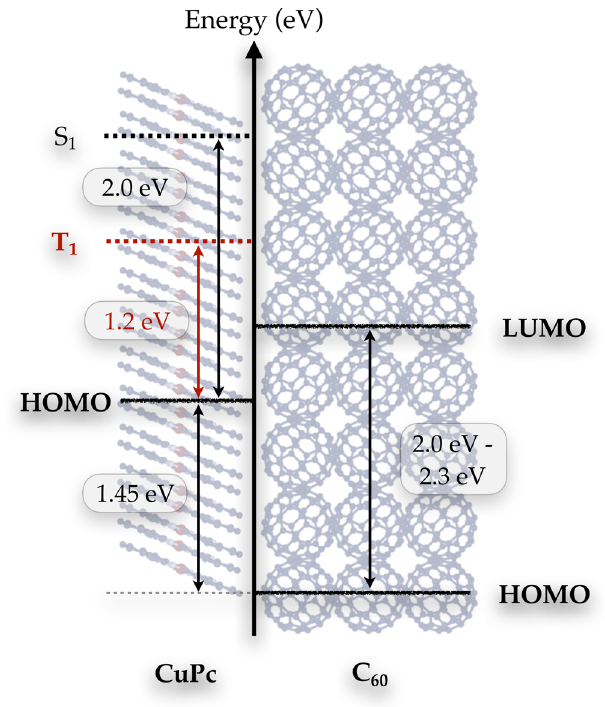
Fig. 1 Schematic energy level diagram of the CuPc:C 60 interface. Energy level diagram of the investigated CuPc:C 60 interface based on values from the literature 3 – 6,13 – 16 . For more information see